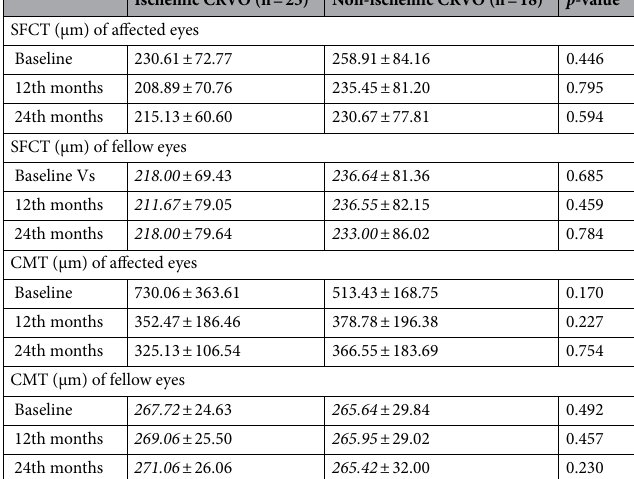
Table 4. Comparison of SFCT and CMT between the ischemic and non-ischemic CRVO groups. Values are presented as mean ± standard deviation unless otherwise indicated. BCVA best-corrected visual acuity, logMAR logarithm of the minimum angle of resolution, SFCT subfoveal choroidal thickness, CMT central macular thickness. Comparison between ischemic and non-ischemic eyes in each period. p- value derived from the Mann–Whitney test. Significant values are in